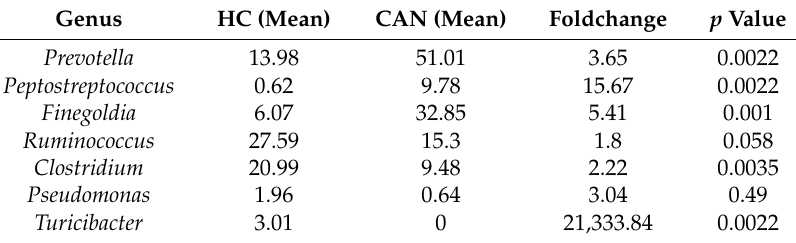
Table 2. Important genera selected by our machine learning